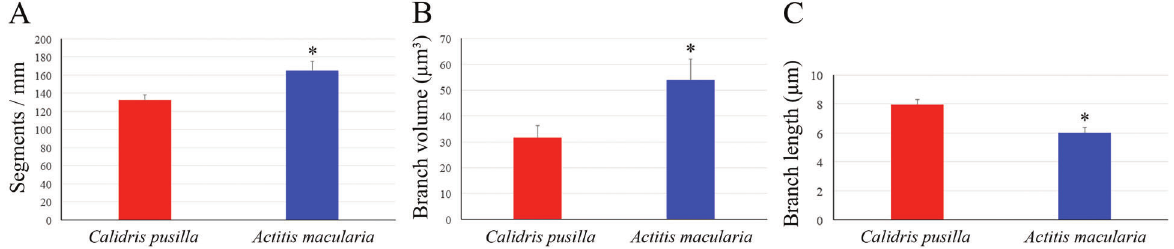
Figure 5. Measurements of sandpiper hippocampus microglial processes. Data are reported as means ± SE for 3 distinct microglial morphological measurements, which showed statistically signi fi cant differences between shorebirds Actitis macularia and Calidris pusilla (two-tailed t -tests, *P o 0.05). Note that, on average, microglial branches from C. pusilla have longer and thinner processes and less dense rami fi cations than those from A. macularia.